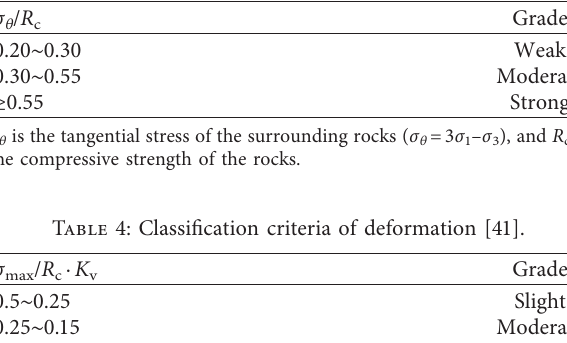
Table 3: Russenes criterion of rock burst